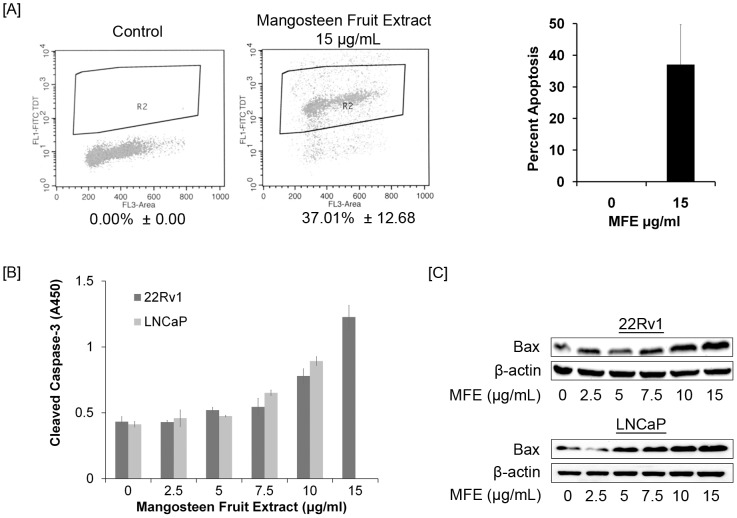
Mangosteen fruit extract (MFE) induced apoptosis and apoptosis-related gene expression in prostate cancer cells.[A], Percentage of apoptotic cells in MFE-treated and untreated cells were determined by flow cytometry. MFE dose was 15 µg/ml. [B], Cleaved Caspase-3 levels in increasing doses of MFE treated 22Rv1 and LNCaP cells. Cell lysates were prepared from MFE-treated cells and cleaved caspase-3 levels were evaluated from same amounts of cell lysates by ELISA, details see
Materials and Methods
. Relative expression levels were indicated as absorbance values at 450 nm (A450). [C], Bax expression in increasing doses of MFE-treated 22Rv1 and LNCaP. Cell lysates were prepared from MFE-treated cells, Bax expression was detected by western blot, and β-actin was used as a loading control. These results are representatives from three independent experiments.